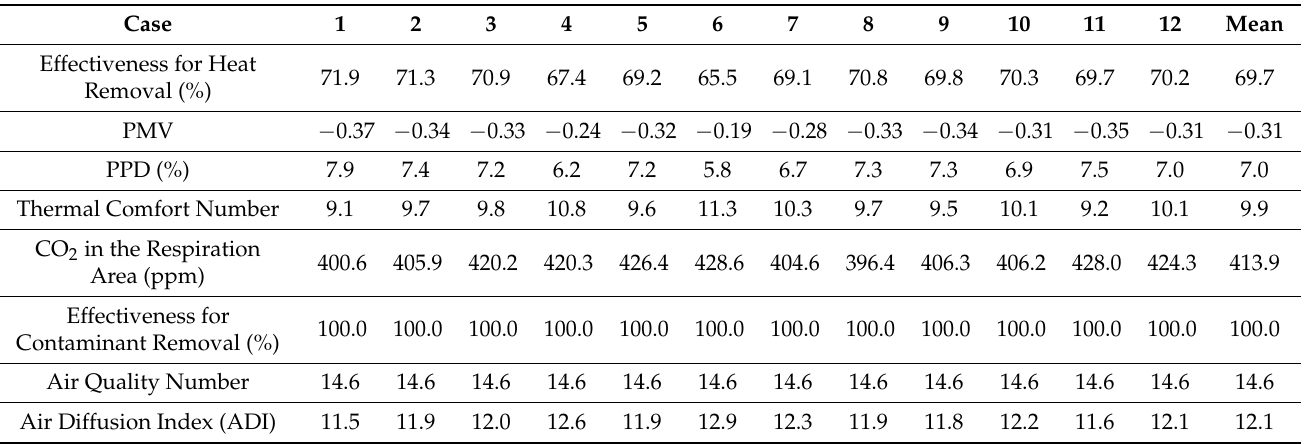
Table 16. ADI obtained for Case VI (0.2722m 3 /s) at 16